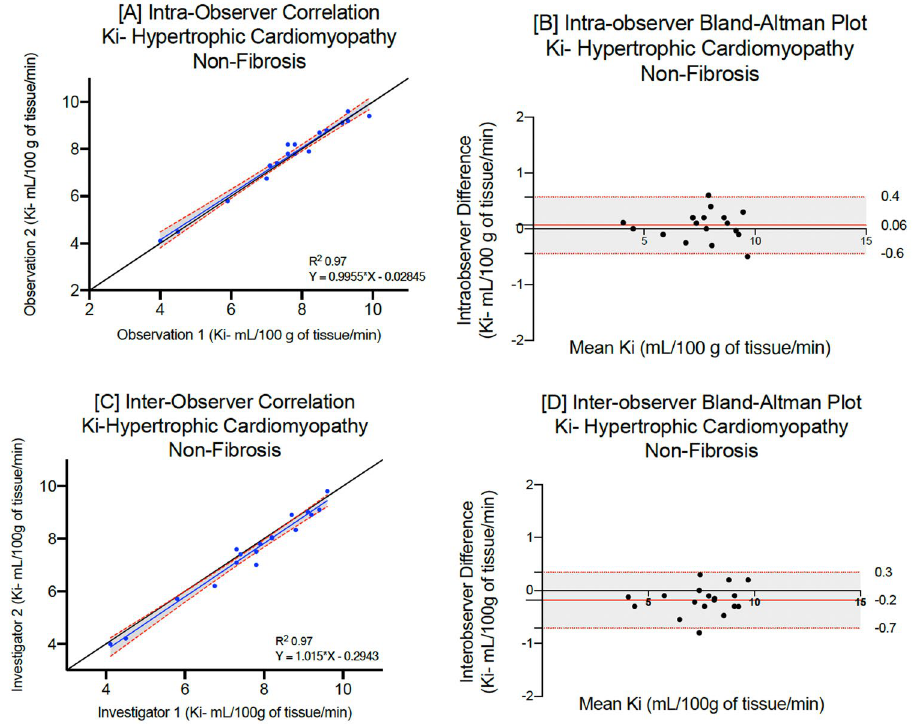
Figure 4. Intraobserver and interobserver repeatability of myocardial manganese uptake in hypertrophic cardiomyopathy. Intra-observer linear regression analysis ( A ) and Bland–Altman plots for myocardial manganese uptake ( B ) in patients with hypertrophic cardiomyopathy. Inter-observer linear regression analysis ( C ) and Bland–Altman plots for myocardial manganese uptake ( D ) in patients with hypertrophic